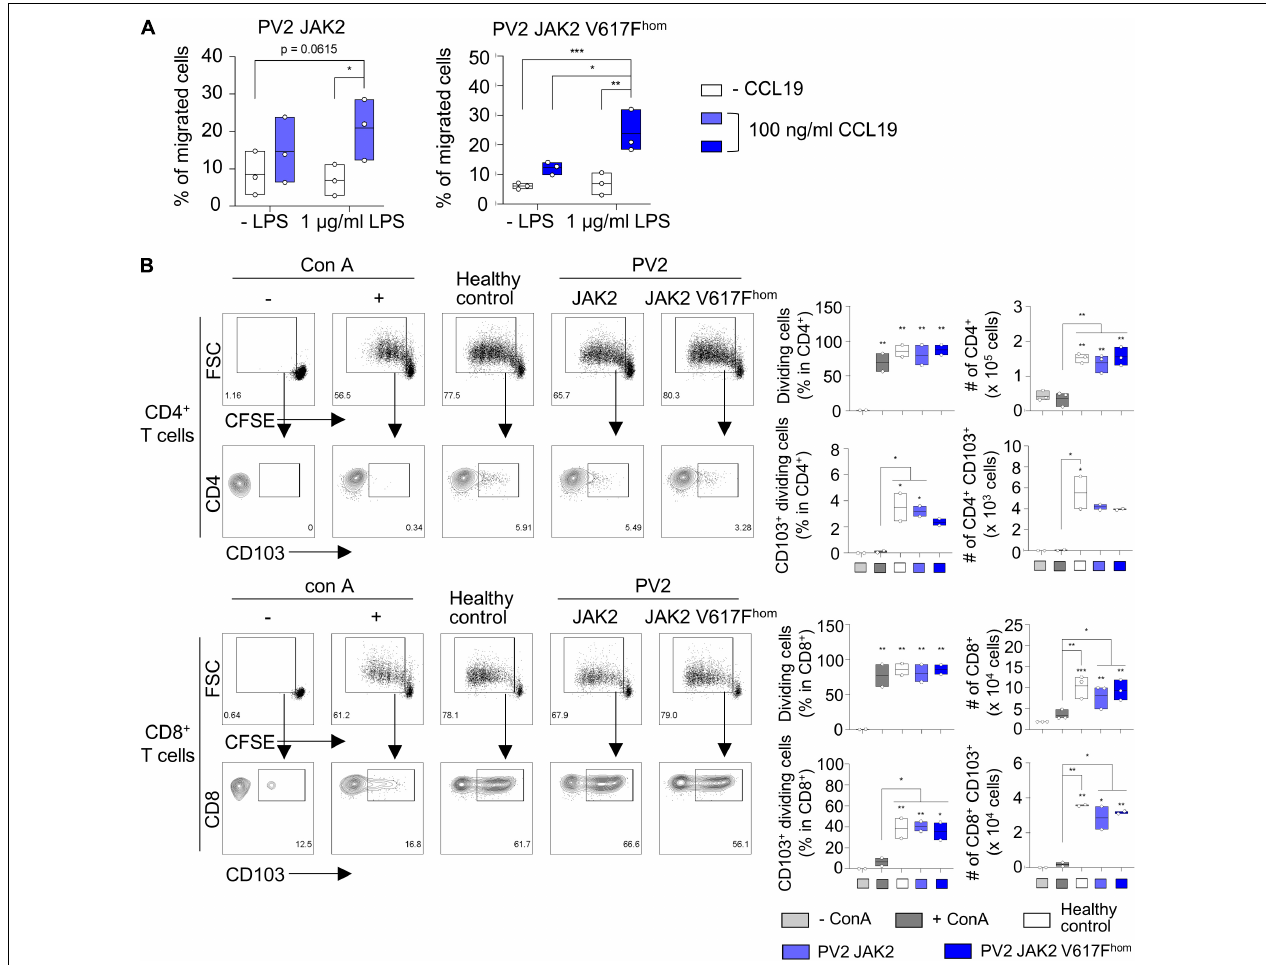
FIGURE 4 | JAK2 V617F hom DC migrate toward CCL19 chemokine and induce polarization of CD8 + T cells toward CD8 + CD103 + tissue resident T cells. (A) DC obtained from JAK2 V617F hom iPS cells (patient PV2) and the respective iPS cells without mutation (JAK2) migrate toward CCL19 chemokine. CD1c + HLA-DR + cells of day 8–9 of DC differentiation were treated with LPS (1 µ g/ml, 24 h) or left untreated and subjected to CCL19 chemotaxis assay. Migrated cells in response to CCL19 were measured by flow cytometry and the percentage of migrated cells is shown. n = 3, line represents mean; * p < 0.05, ** p < 0.005, two-way ANOVA with uncorrected fisher’s LSD test. (B) DC obtained from patient PV2 iPS cells as in (A) and from healthy donor iPS cells (healthy control) induce CD4 + and CD8 + T cell proliferation in MLR assays. CD1c + HLA-DR + cells on day 8–9 of DC differentiation were stimulated with LPS (1 µ g/ml, 24 h) and co-cultured with CFSE labeled T cells for 5 days and CD4 + and CD8 + T cell proliferation was determined by flow cytometry. Representative flow cytometry analysis and quantification of percentage and number of dividing CD4 + , CD8 + , and/or CD103 + T cells are shown. ConA-stimulated and unstimulated T cells, positive and negative control, respectively. n = 2–3, independent experiments and independent healthy donors; line represents mean; * p < 0.05, ** p < 0.005, *** p < 0.001, one-way ANOVA with Tukey’s multiple comparisons test vs. unstimulated T cells or as